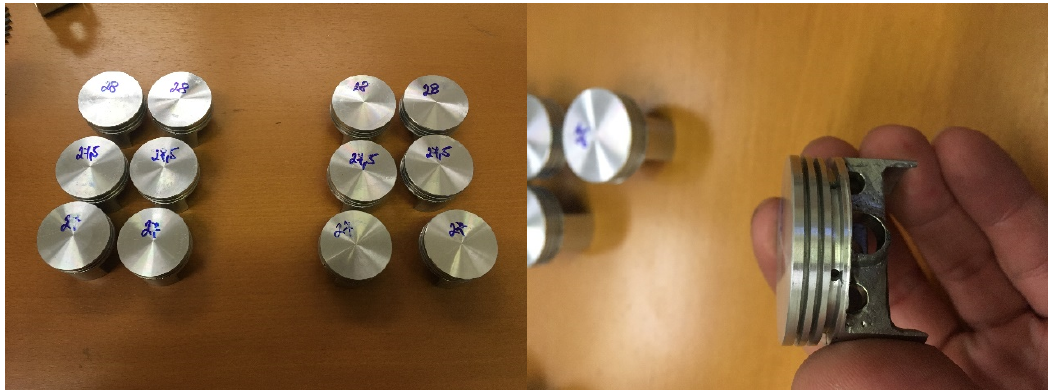
Figure 15. Manufactured pistons with different numbers of grooves for piston rings and different compression ratios.